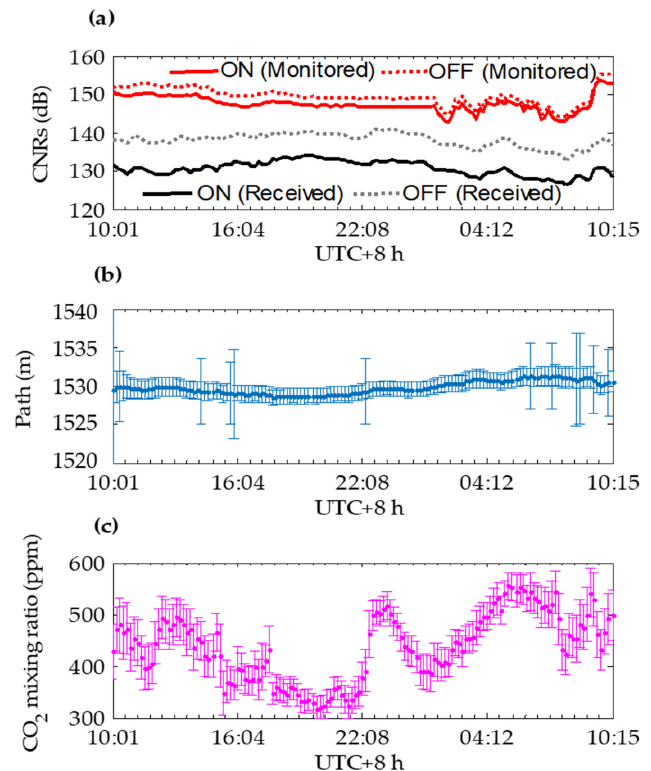
Figure 2. ( a ) The carrier-to-noise ratio (CNRs) of the receiving and monitoring signals for both the on and off wavelengths; ( b ) the path length; and ( c ) the CO 2 concentration in Shanghai city for one day during the first trial.